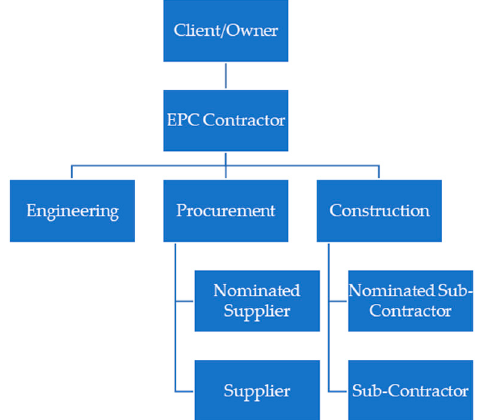
Figure 1. EPC project organization chart.